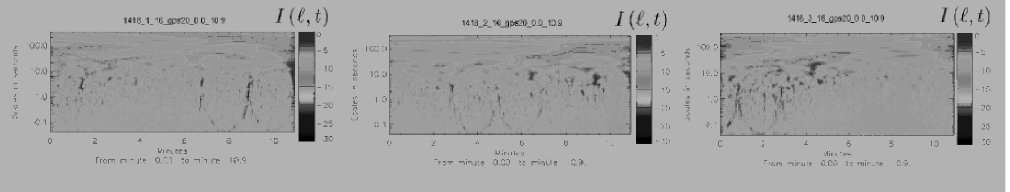
Fig. 14. Sideral-periodic features in a scalogram, probably of non-geophysical